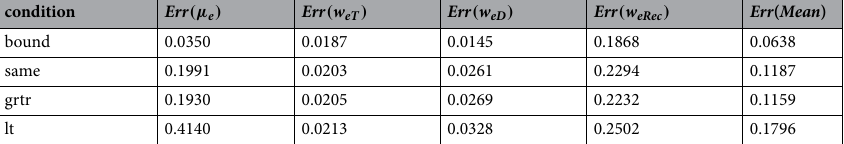
Table 5. Error values for Physical Model-4 for (cid:31) 1 = 0.1 at different conditions. Err (µ e ) , Err ( w eT ) , Err ( w eD ) , Err ( w eRec ) are the error values in the drift, trapping, detrapping and recombination coefficients of the electrons respectively. Err ( Mean ) is the arithmetic mean each of these error values.